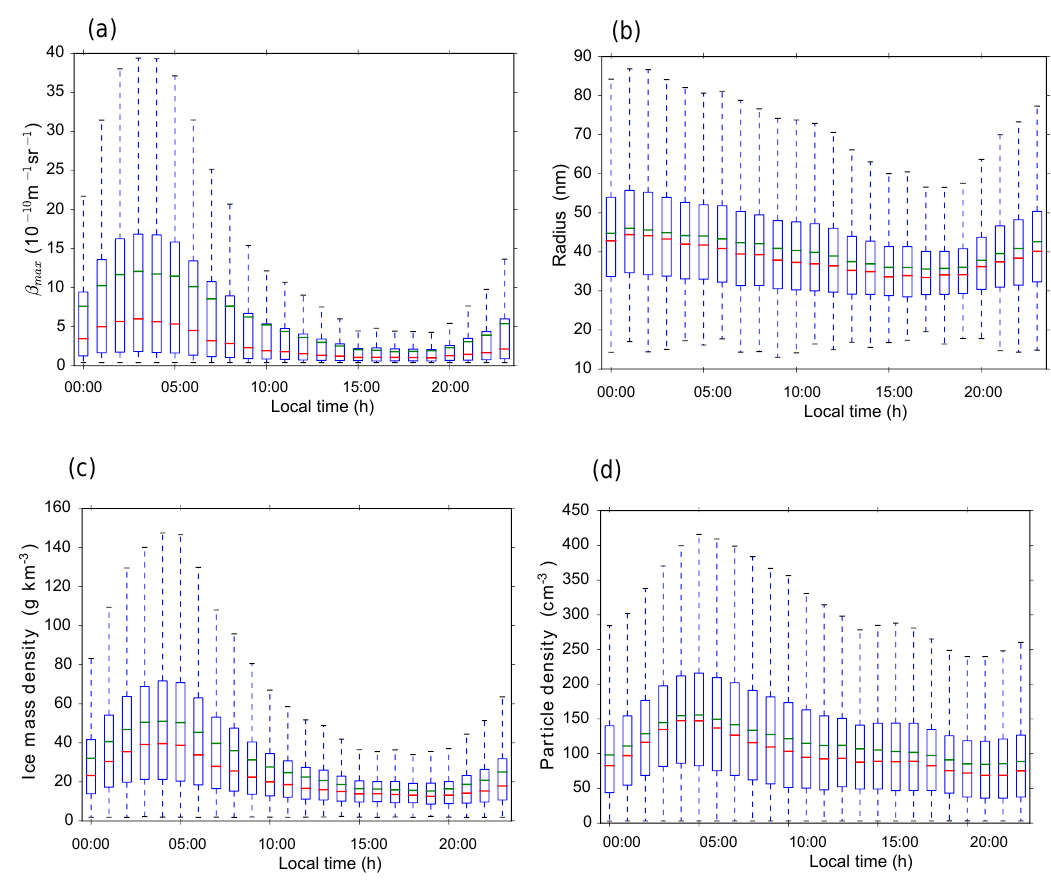
Figure 7. Ice parameters at 67–71 ◦ N calculated from MIMAS simulations of all July months 2003–2013 for the altitude range near 83km where β max >0.4. (a, b) Brightness and ice particle radius. (c, d) Ice mass density and particle number density. The boxes represent lower and the upper quartiles, median (red line), and arithmetic mean (green line). The dashed vertical bars indicate the minimum and maximum values.